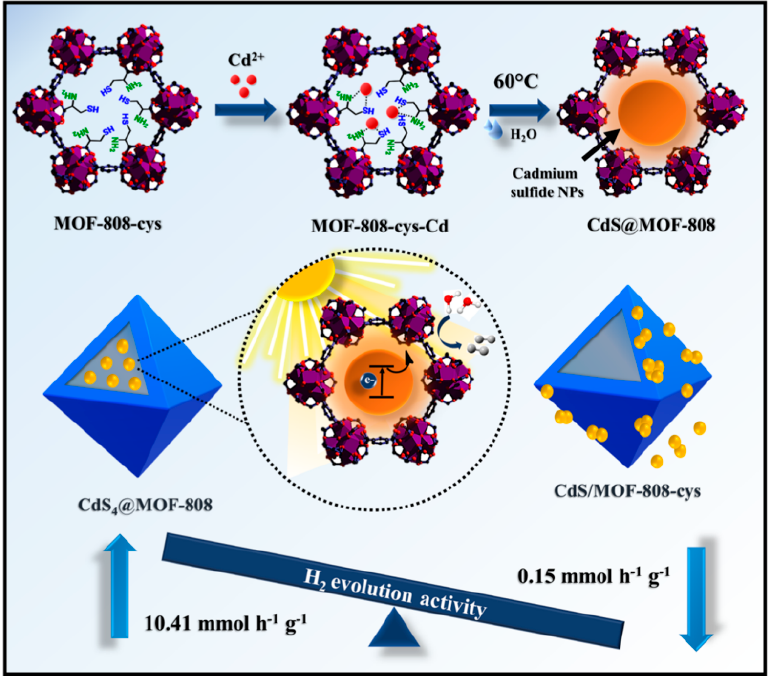
Figure 9. Illustration of the preparation of CdS@MOF-808 composites and the comparison of hydro- gen production rates between CdS 4 @MOF-808 and CdS/MOF-808-cys. Reproduced with permission from Ref. [72].